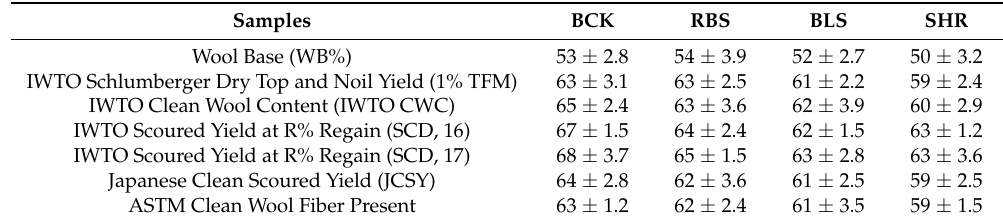
Table 3. Various calculated commercial wool yields.